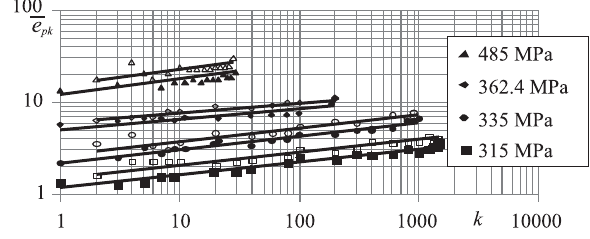
Fig. 6. Dependence of hysteresis loop width on Fig. 7. Accumulated plastic strain at the symmetric cycle (a); accumulated plastic strain at the pulsating cycle